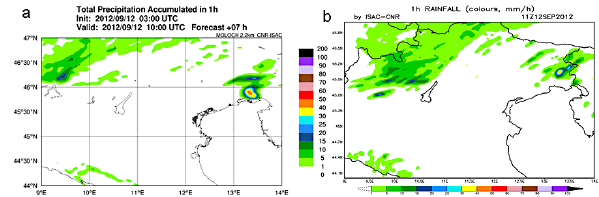
Figure 7. Hourly accumulated precipitation on 12 September: (a) : at 10:00UTC, forecast by MOLOCH-ISAC; (b) : at 11:00UTC, forecast by